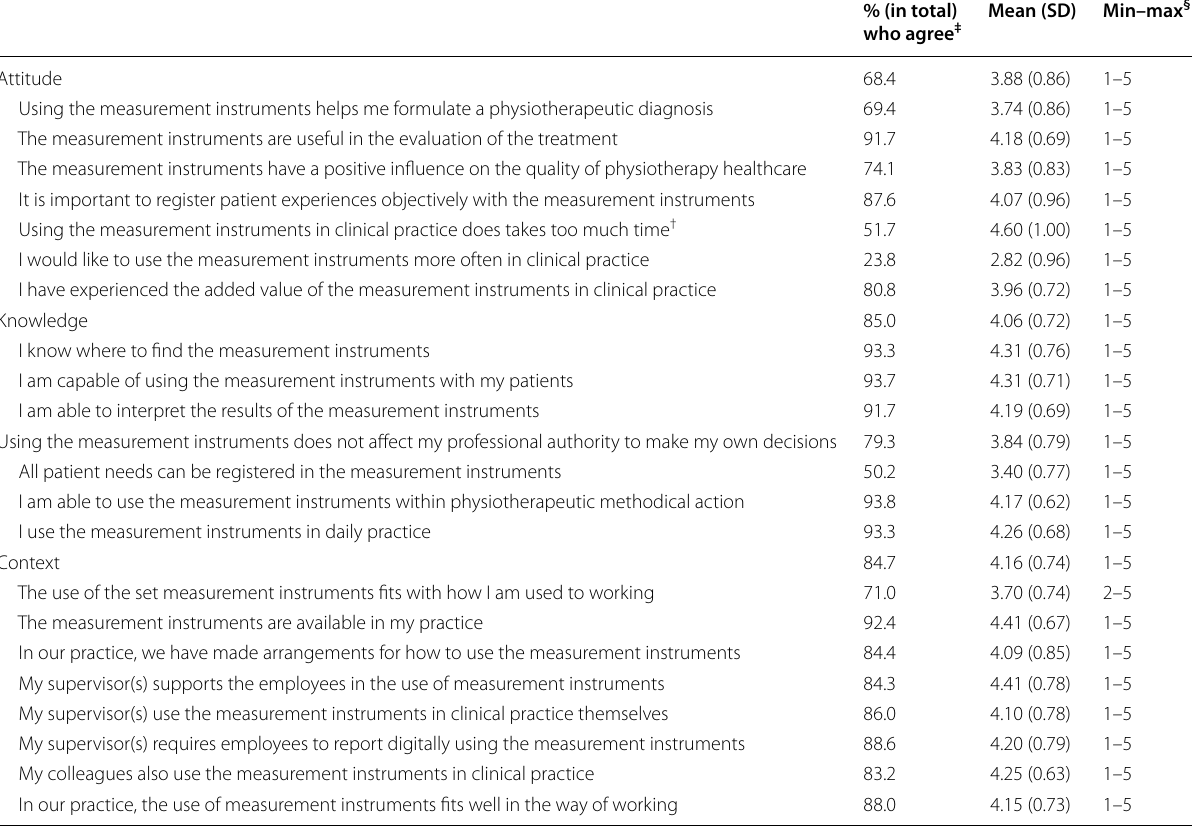
Table 2 Results of the survey on attitude, knowledge, and